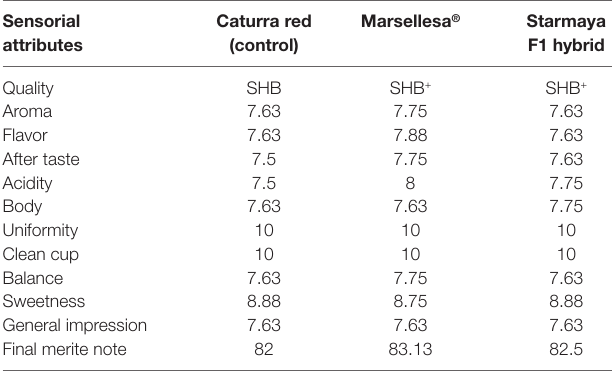
TABLE 8 | Cup sensorial attributes of coffee beans from Caturra red, Marsellesa ® , and Starmaya F1 hybrid of C. arabica .